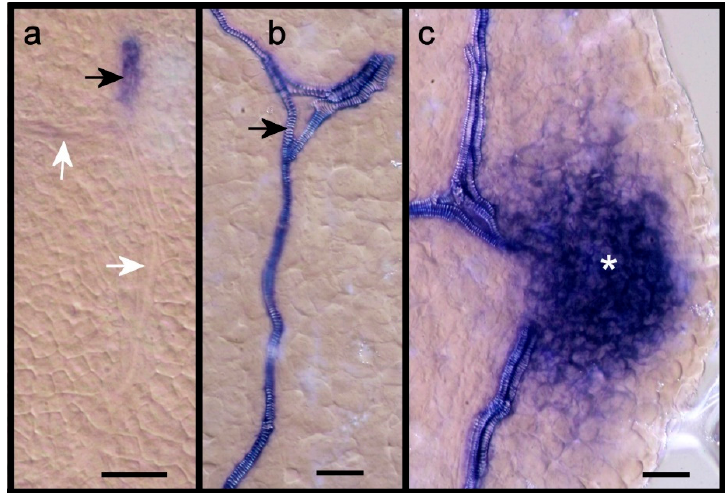
Figure 4. Expression of ARF19 during vein differentiation. ( a ) Expression in differentiating vessel element extending towards leaf margin (black arrow) but not in younger procambial secondary veins (white arrows), ( b ) expression in differentiating vessel elements (black arrow), ( c ) expression in the hydathode region of a leaf serration (white asterisk). Size bars, 20 µm.